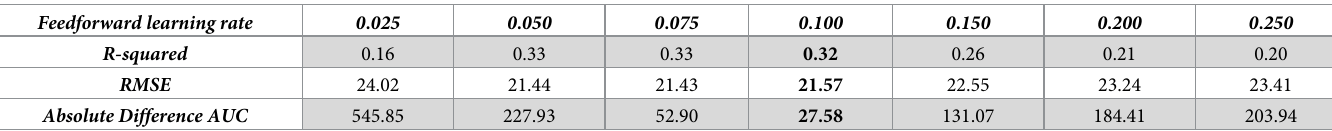
adaptive paradigm explained by model simulations. AUC = area under the curve. o